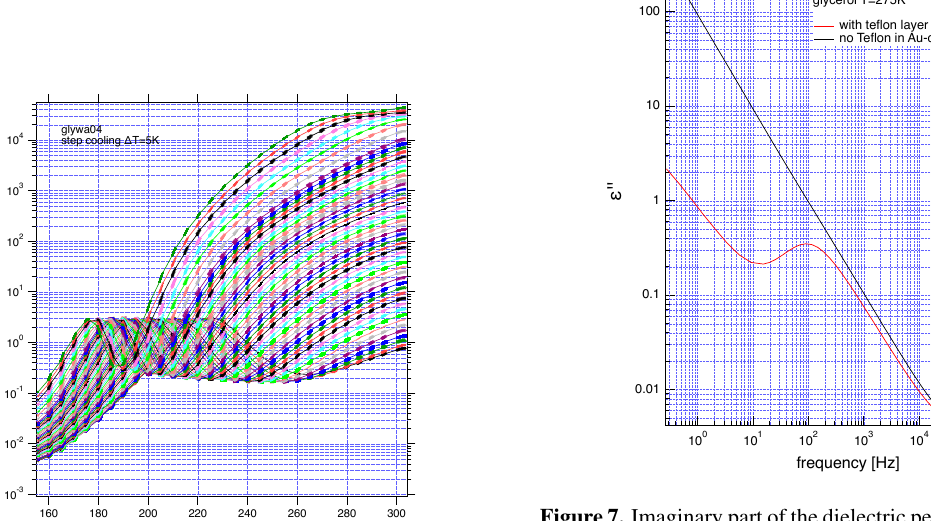
Figure 7. Imaginary part of the dielectric permittivity of glycerol with and without a Teflon covered electrode. A peak appears with Teflon coverage as discussed in the text. (cid:15) (cid:48)(cid:48) for glycerol with standard Teflon windows (black curve) is scaled down by 0.55 to match roughly the minimum seen near 5 · 10 4